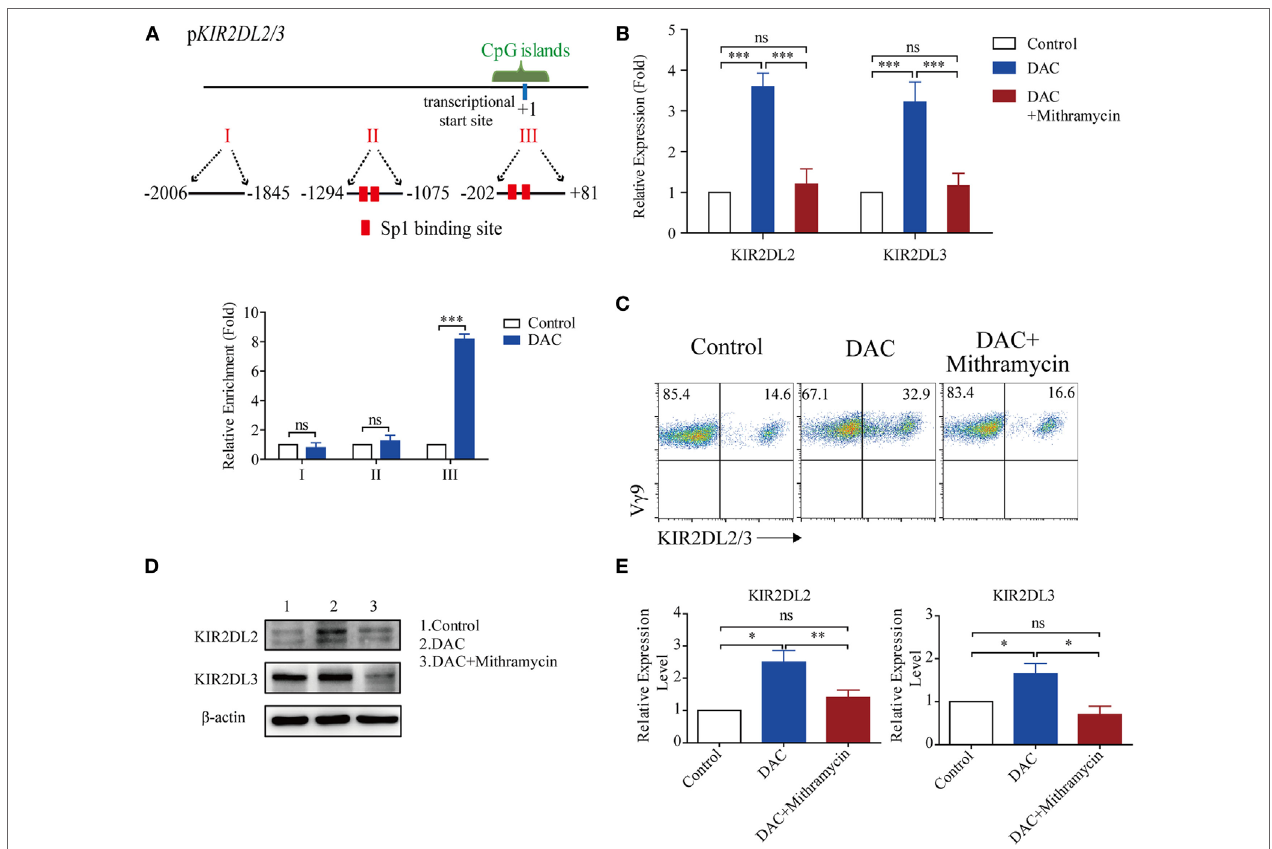
FigUre 5 | Decitabine increased KIR2DL2/3 expression by ligation of Sp-1 and its binding sites. (a) Three regions (I, II, and III) including transcriptional star site ( + 1) of KIR2DL2/3 were analyzed by chromatin immunoprecipitation qPCR for Sp-1 occupancy in KIR2DL2/3 promoter of gamma delta ( γδ ) T cells treated with and without (control) DAC for 48 h. Data are shown from three independent experiments and each PCR was performed in triplicate (*** p < 0.001; ns, not significant). (b) The effect of the Sp-1-inhibitor mithramycin on KIR2DL2 and KIR2DL3 expression in DAC-treated γδ T cells. qRT-PCR analysis of KIR2DL2 and KIR2DL3 expression in γδ T cells, γδ T cells treated with 0.5 µM DAC and γδ T cells treated with 0.5 µM DAC and 100 µM mithramycin for 48 h. Data are expressed as the relative expression of KIR2DL2 and KIR2DL3 mRNA in different groups (*** p < 0.001; ns, not significant; n = 3). (c) Flow cytometry analysis of the effect of the Sp-1-inhibitor mithramycin on DAC-treated γδ T cells. γδ T cells were treated with 0.5 µM DAC and 0.5 µM DAC plusing 100 µM mithramycin for 48 h, respectively. Representative FACS results illustrate KIR2DL2 and KIR2DL3 expression on γδ T cells, DAC-treated γδ T cells, and γδ T cells treated with both DAC and mithramycin. (D) Western blot analysis of the effect of mithramycin on DAC-treated γδ T cells. γδ T cells were treated with 0.5 µM DAC and 0.5 µM DAC plusing 100 µM mithramycin for 48 h, respectively. A representative western blot illustrates KIR2DL2 and KIR2DL3 expression on γδ T cells, DAC-treated γδ T cells, and γδ T cells treated with both DAC and mithramycin. β -Actin was used as a loading control of the cell lysates. (e) Bands of KIR2DL2 and KIR2DL3 were quantified by densitometric analysis and plotted after normalization against β -actin. The histogram shows means ± SD for three independent sets of experiments (* p < 0.05; ** p < 0.01; ns, not